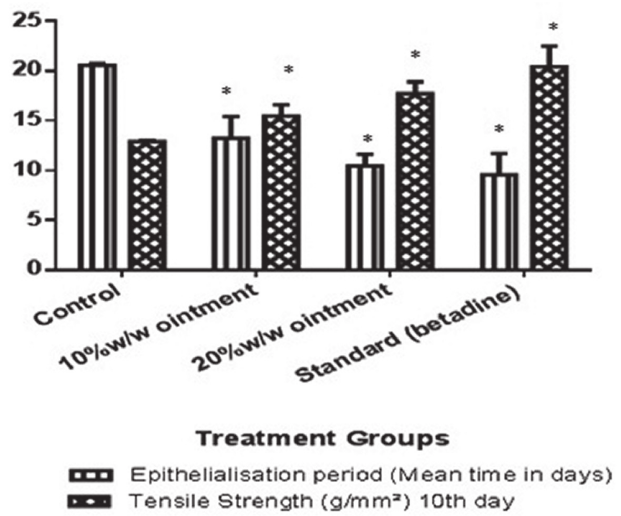
FIGURE 1 - Measurement of epithelialisation and tensile strength in incision wound